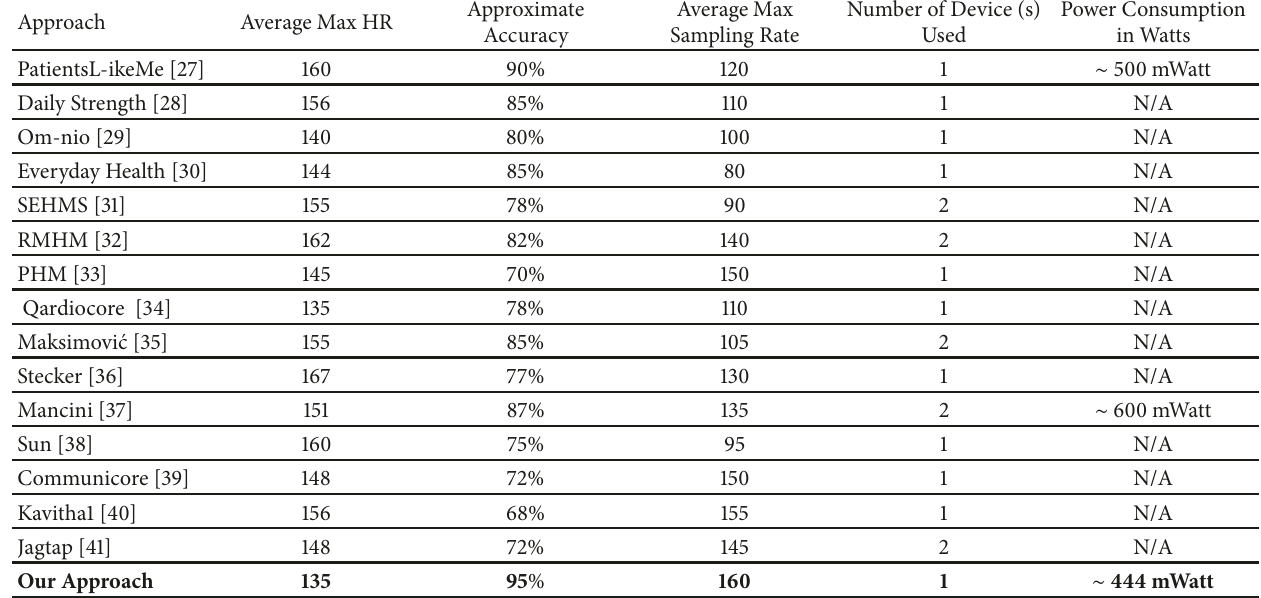
Table 2: Quantitative comparison of existing work based on different